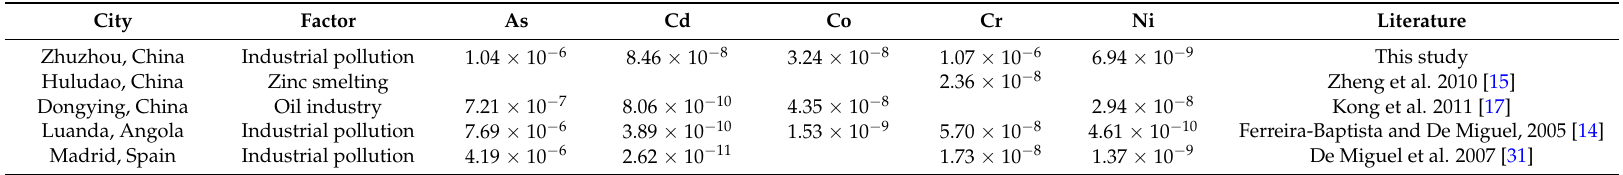
Table 7. Comparisons of cancer risk for child in urban dust of different